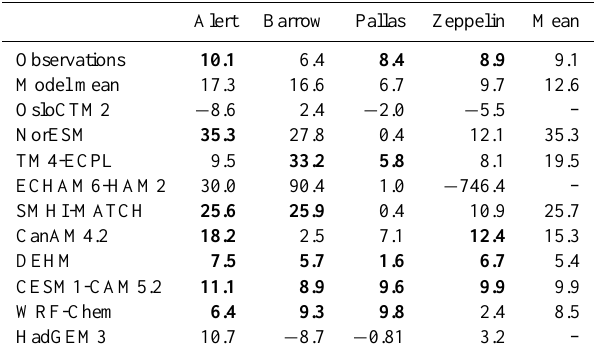
Table 3. Slopes of regression lines between monthly mean concen- trations of sulfate and (e)BC for the different stations. Slopes are calculated both for the observations and the model values. Values that are statistically significant at the 99.9% level are written in bold font. For the mean over all sites/models, only the statistically significant values were